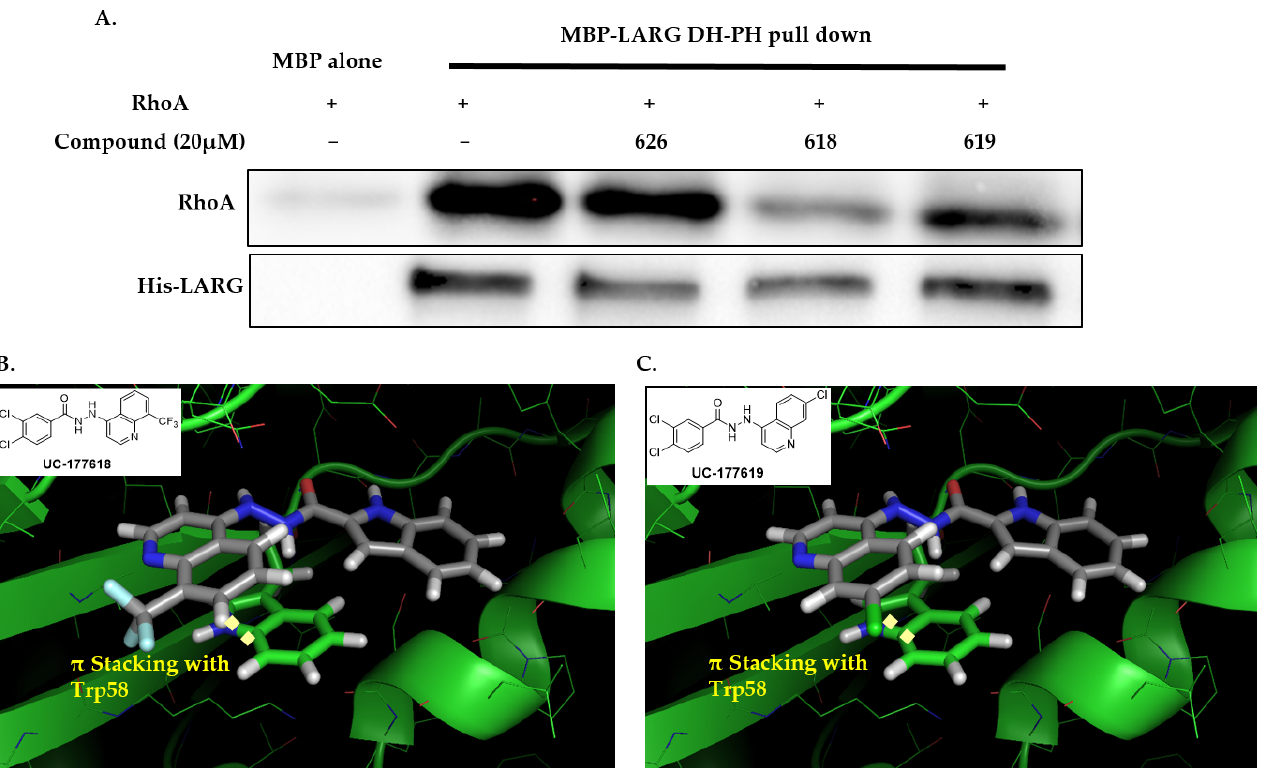
Figure 3. UC-177618 and UC-177619 inhibit RhoA-LARG interaction. ( A ) A complex-formation assay tested the inhibitory effects of 20 µM UC-177618 and UC-177619 on RhoA interaction with the LARG DH-PH domain. MBP-(His)6-tagged LARG (100 ng) was immobilized on Amylose beads, to which binding buffer containing full-length RhoA (100 ng) preincubated with UC-177618, UC-177619, or UC-177626 (an inactive Rhosin-related compound) was added. After incubating the compound-RhoA-LARG mixture at 4 °C for 1 h, the beads associated with RhoA were detected with anti-RhoA Western blotting. ( B,C ) Top view of the predicted structural contacts of UC-177618 and UC-177619 in the binding pocket around the Trp58 residue of RhoA.